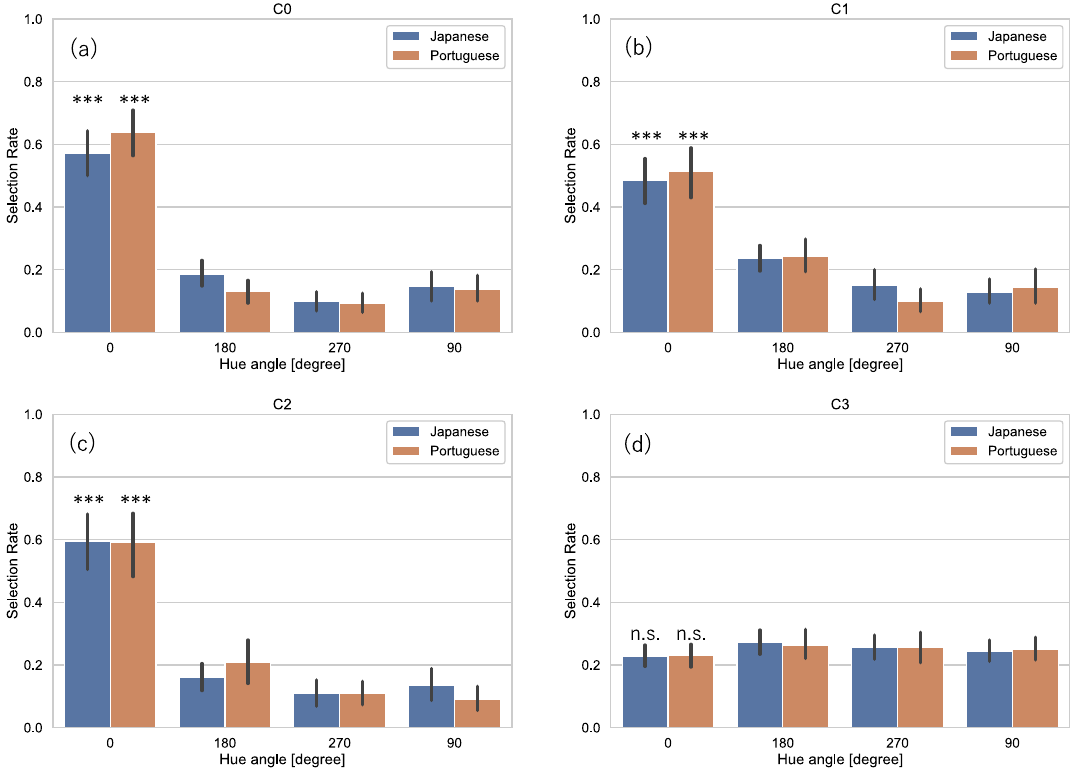
Figure 5. Average selection rates measured in the replication experiment. The format is identical to Fig. 4.